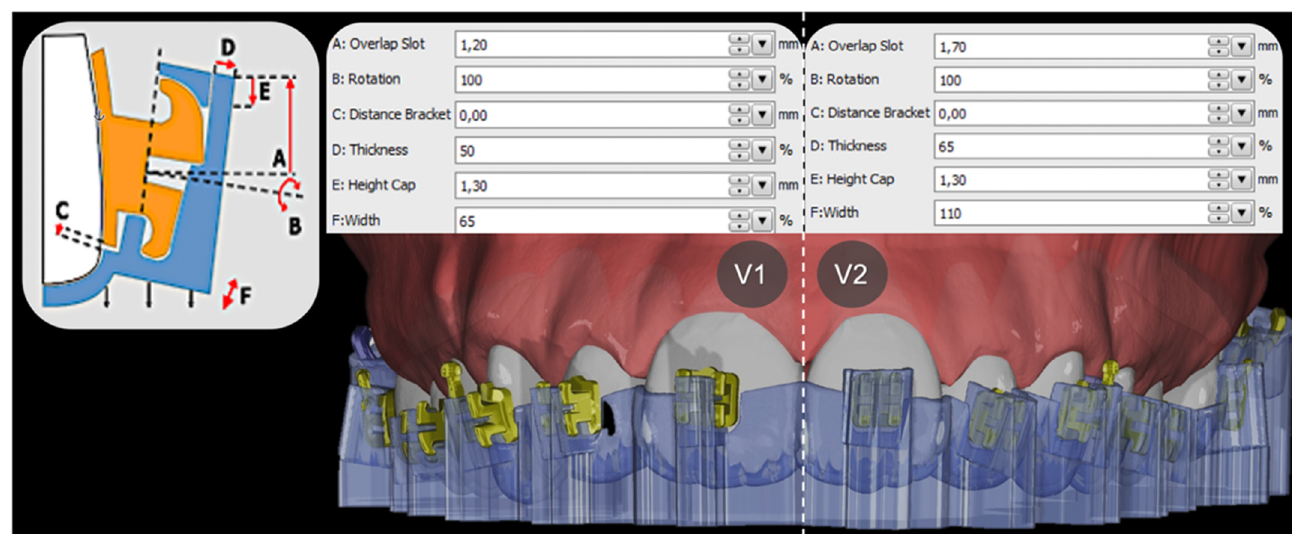
Figure 2. Comparison between version 1 ( V1 ) and version 2 ( V2 ) tray design and the selected setting parameters. Left: Graphic representation in OnyxCeph³™ of the design possibilities.